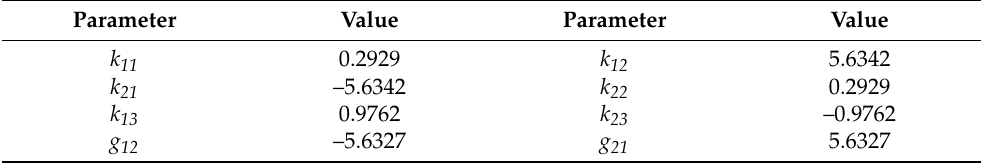
Table A4. Constants and gain values.